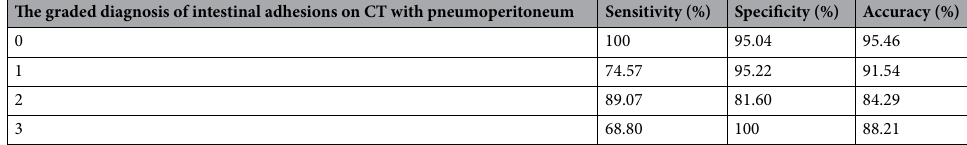
Table 3. Results of the graded diagnosis of intestinal adhesions on CT with pneumoperitoneum.